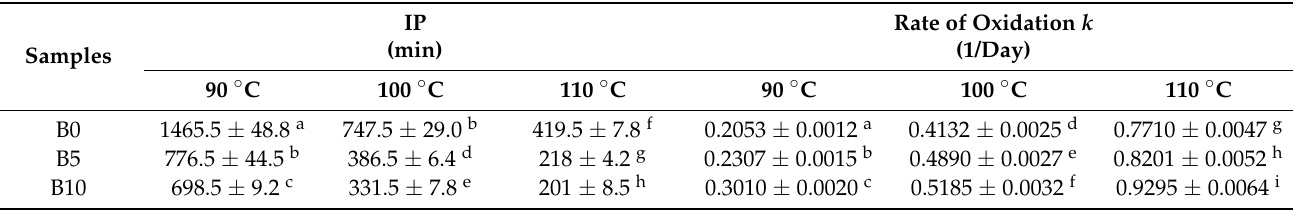
Table 1. Induction period (IP) and rate of oxidation k of control and fortified with grape pomace (GP) breadsticks. OXITEST was set at temperatures 90, 100, and 110 ◦ C.